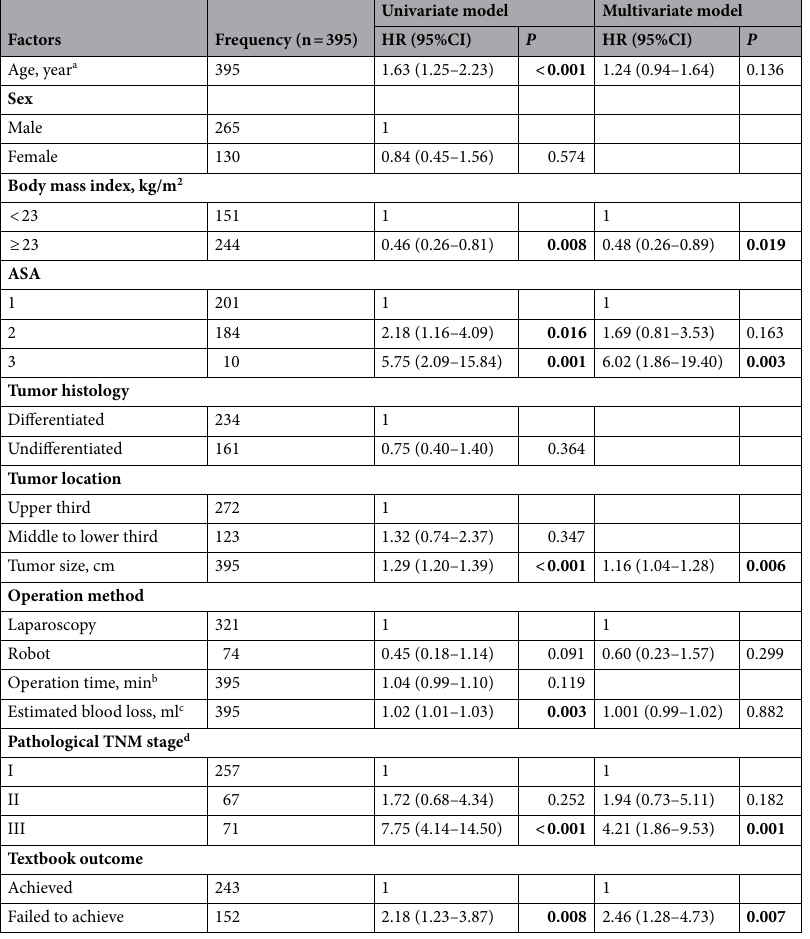
Table 3. Univariate and multivariate Cox regression models for overall survival. Statistically significant values ( P < 0.05) are given in bold. HR hazard ratio, CI confidence interval, ASA American Society of Anaesthesiologists. a The hazard ratio shown is for every 10 year increase in age. b The hazard ratio shown is for every 10 min increase in operation time. c The hazard ratio shown is for every 10 ml increase in estimated blood